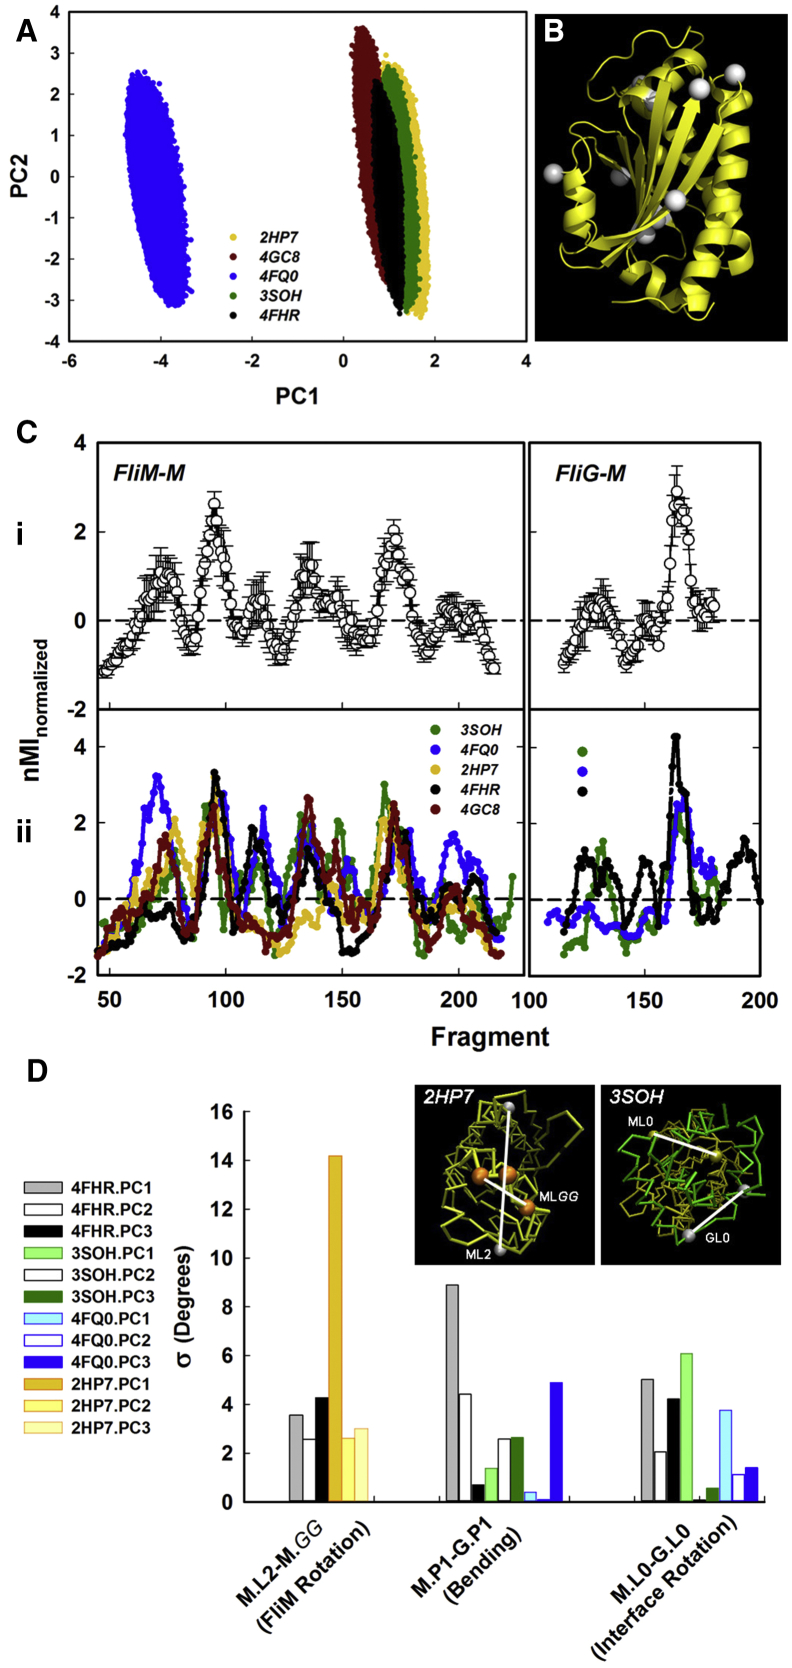
Comparative Dynamics of FliM Structures(A) PC1PC2 plots of FliMM ensembles from the monomers (PDB: 2HP7, 4GC8) and complexes (PDB: 3SOH, 4FQ0, 4FHR). The PC1-PC3 conformer spread (σ) was 0.628 ± 0.002 (PDB: 2HP7) and 0.578 ± 0.002 (PDB: 4GC8); 0.448 ± 0.002 (PDB: 3SOH), 0.578 ± 0.002 (PDB: 4FQ0), and 0.582 ± 0.002 (PDB: 4FHR).(B) Dynamic network nodes (white spheres) mapped onto the PDB: 4FHR FliMM backbone.(C) Hinge detection from the fragment nMIPC, contribution. (i) Averaged nMIPC1 profile (±σ). (ii) Individual nMIPC1 profiles. Pcorr values (PDB: 4FHR reference) were 0.43 (PDB: 2HP7), 0.52 (PDB: 4GC8), 0.44 (PDB: 3SOH), and 0.57 (PDB: 4FQ0).(D) First three PC distribution σ of the bending and rotary motions of PDB: 4FHR and FliMMFliGM complexes measured with vector pairs as defined in Figure 3D. Insets: snapshots from Movie S4 (PDB: 2HP7) and Movie S5 (PDB: 3SOH) documenting PC1 and complete PC motions.See also Figure S5.